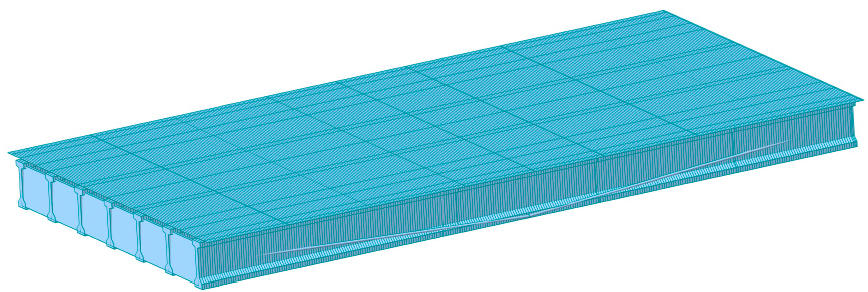
Figure 1. PSC I ‐ girder bridge model with external tendon at both ends of girder. Table 1. Material and sectional properties of the bridge components.